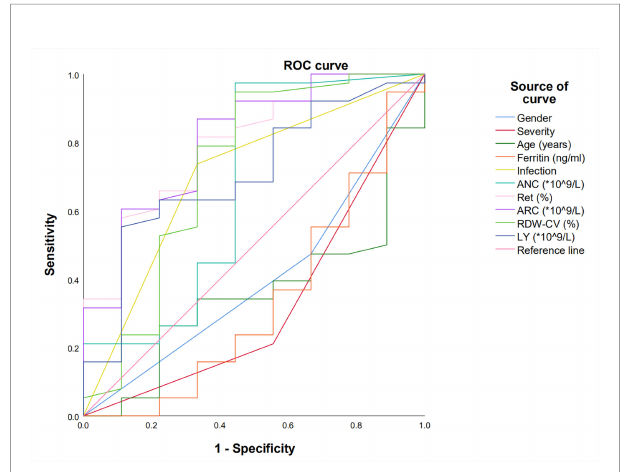
FIGURE 1 | Receiver operating characteristic (ROC) curve was used to predict factors in fl uencing the effect of E-PAG at 6 months. Reticulocyte percentage, ARC, RDW-CV and ALC with AUC more than 0.7.